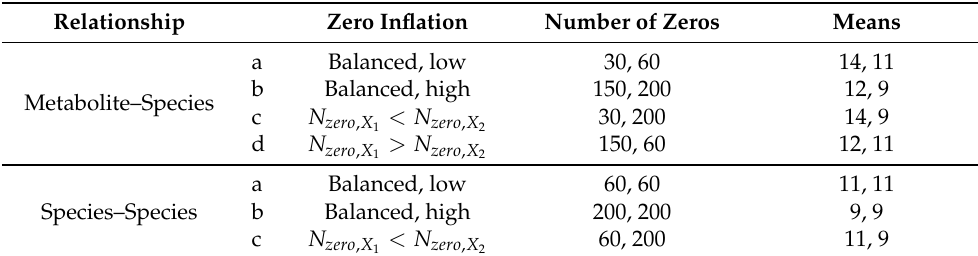
Table 1. Marginal log-scale means (before introducing zeros) and number of zeros for simulation of bivariate lognormal vectors with excess zeros that represent metabolite–species pairs (where X 1 represents a metabolite and X 2 represents a species) and species–species pairs. Levels of zero inflation include balanced (similar number of zeros in each vector), with either low or high zero inflation, and unbalanced (one vector has substantially more zeros than the other). The letter labels (a, b, c, d) of each combination denote different simulation scenarios in that the different zero inflation parameters were used to obtain results for each line of Appendix A Table